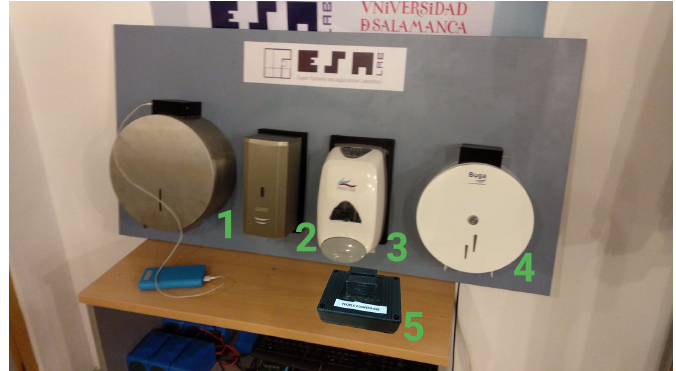
Figure 13. Finished devices: 1 and 4 indicate two toilet paper dispensers, 2 and 3 denote the hydrogel dispensers, and 5 indicates the people